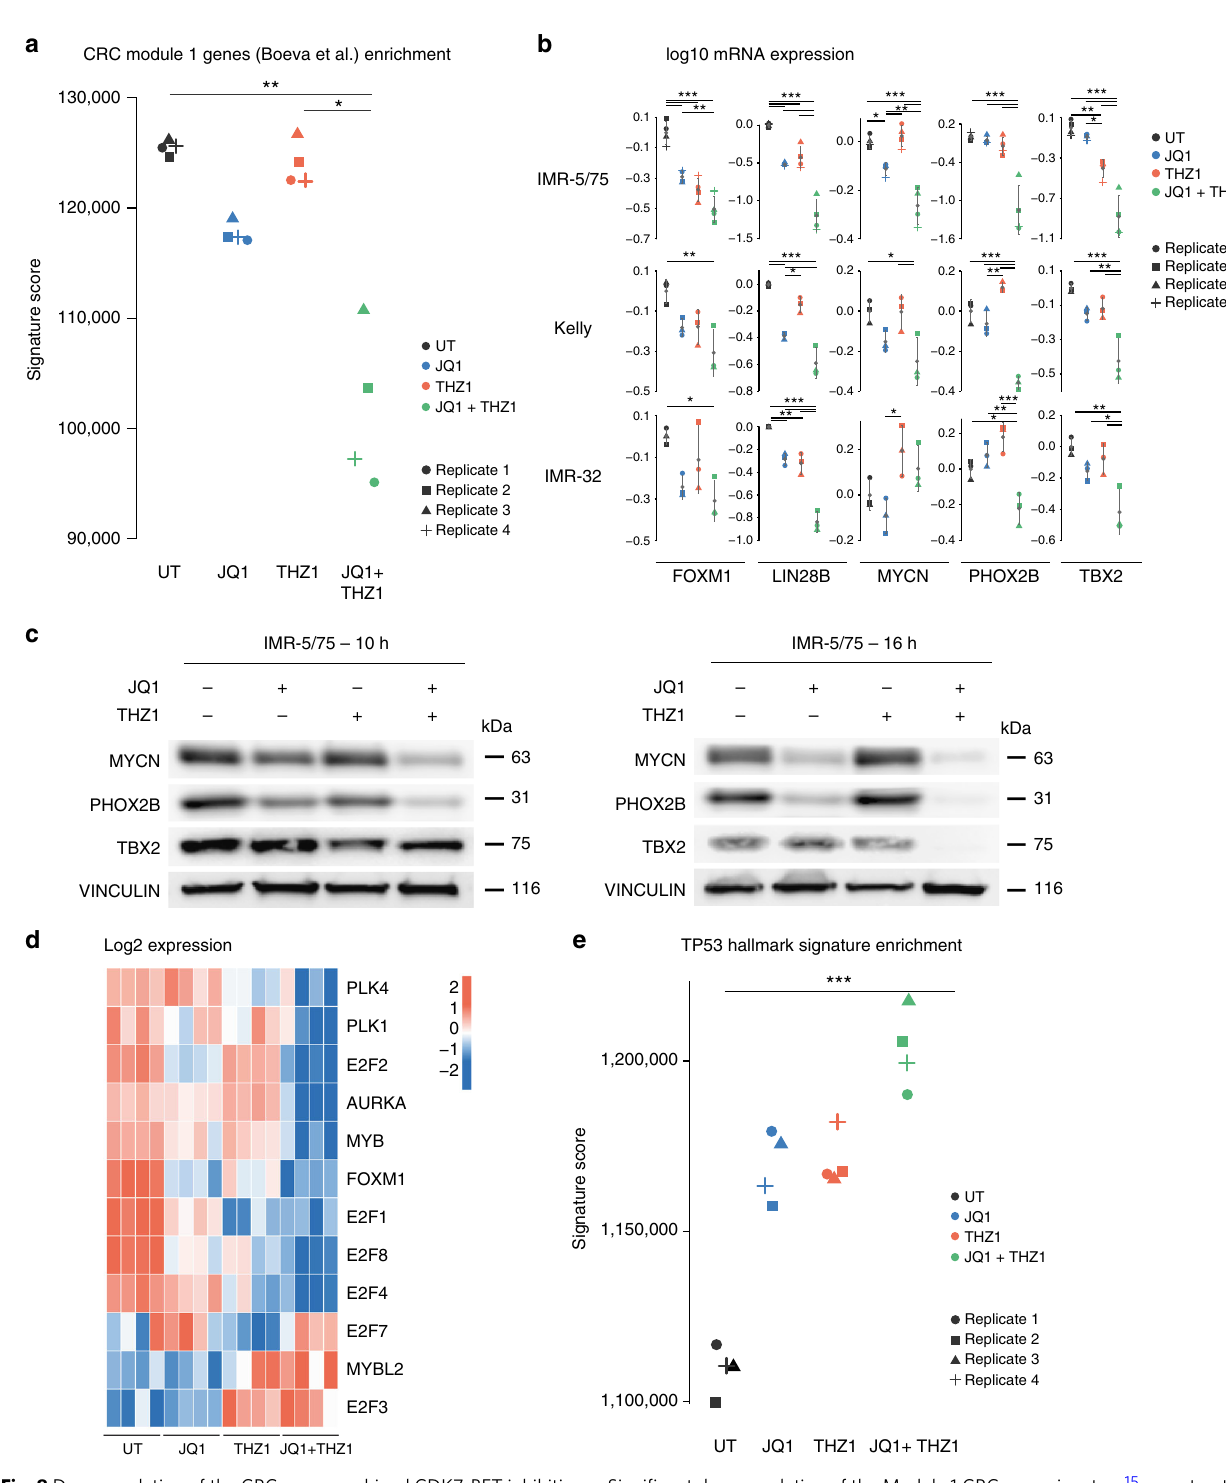
Fig. 8 Downregulation of the CRC upon combined CDK7-BET inhibition. a Signi fi cant downregulation of the Module 1 CRC gene signature 15 upon treatment with 1 µ M JQ1, 35 nM THZ1 and the combination in the IMR-5/75 cell line for 10 h. Kruskal – Wallis followed by a post-hoc Dunn ’ s multiple comparisons test (four biological replicates per condition). b log10 TBX2 , FOXM1 , PHOX2B , MYCN, and LIN28B mRNA levels 10 h upon treatment with 1 µ M JQ1, 35 nM THZ1 and the combination of JQ1 and THZ1 in the IMR-5/75, Kelly and IMR-32 cell lines. Error bars represent the s.d. of the three or four biological replicates. ANOVA statistical analysis followed by a post-hoc Tukey ’ s test for multiple comparisons. c MYCN, PHOX2B, and TBX2 protein levels 10 h and 16 h upon treatment with 1 µ M JQ1, 35 nM THZ1 and the combination of JQ1 and THZ1 in the IMR-5/75 cell line. d Heatmap showing the expression levels for